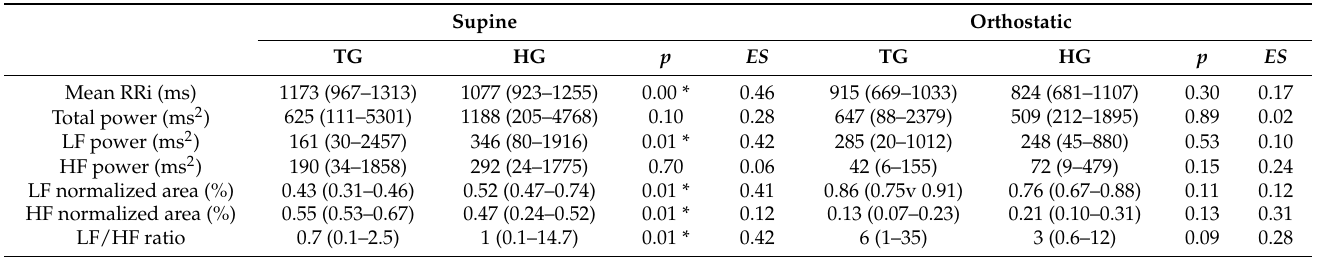
Table 2. Median (25th, 75th percentiles) of the mean RR intervals and the frequency-domain indices of the triathlon group (TG; n = 16) and the high-intensity interval training combined with different types of exercises group (HG; n = 18) in supine and orthostatic